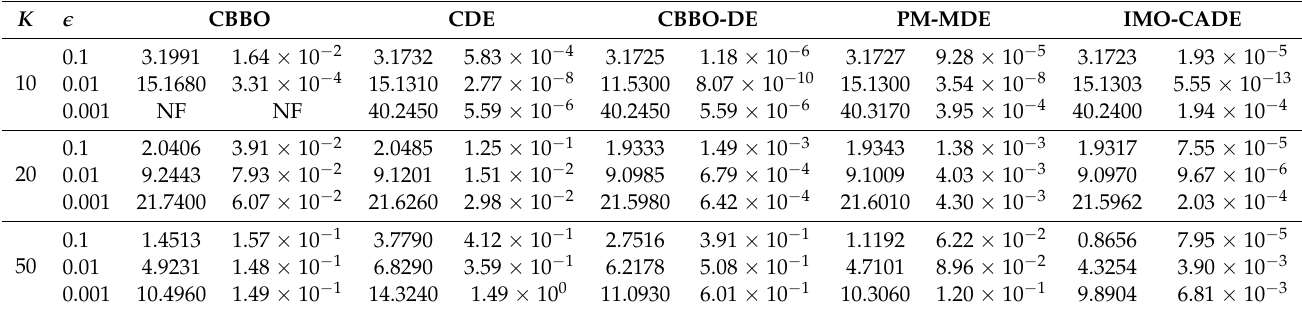
Table 3. Comparison with the reported results for the OPA under i.i.d. observations, where “NF” indicates that no feasible solution is obtained.